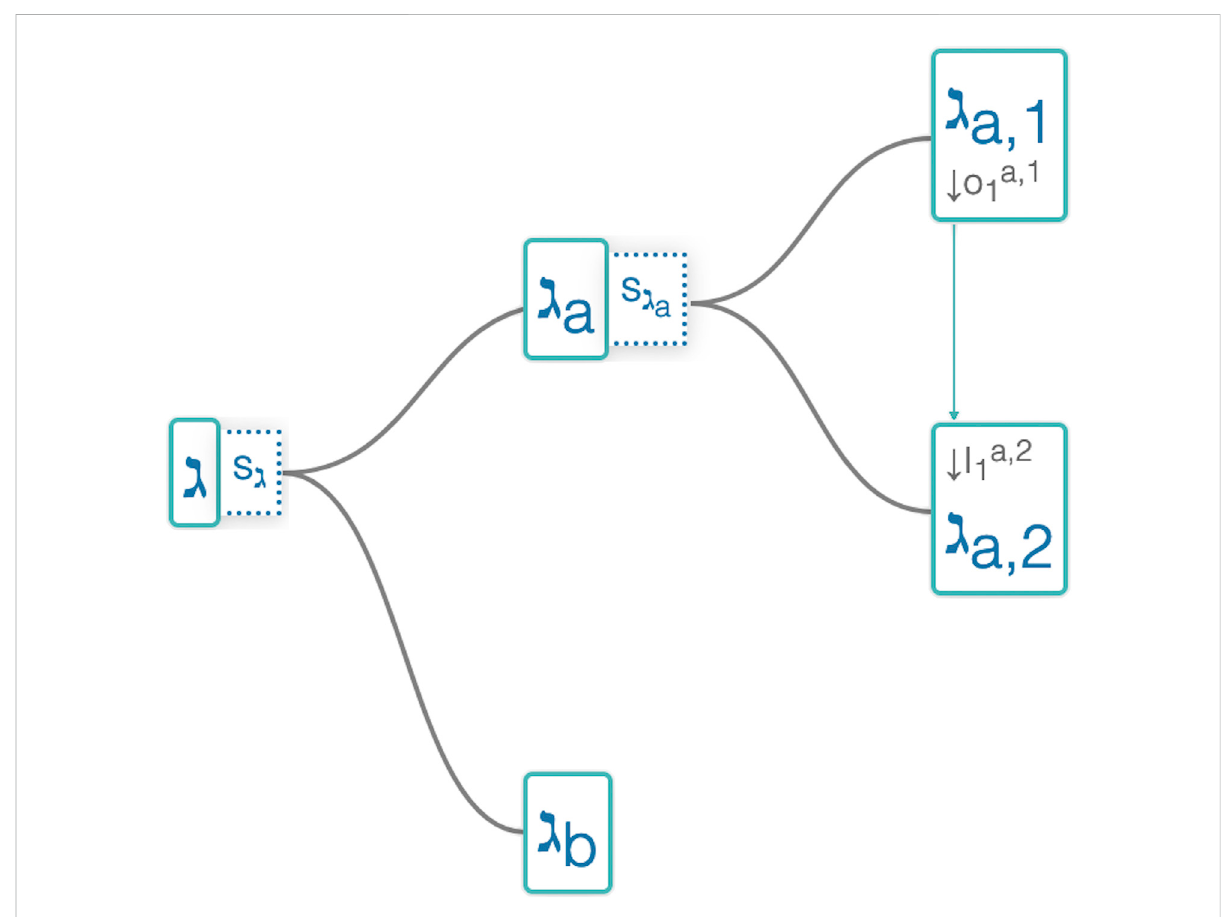
FIGURE 1 Example of joint activity graph representation showing decomposition, synthesis and data binding between two